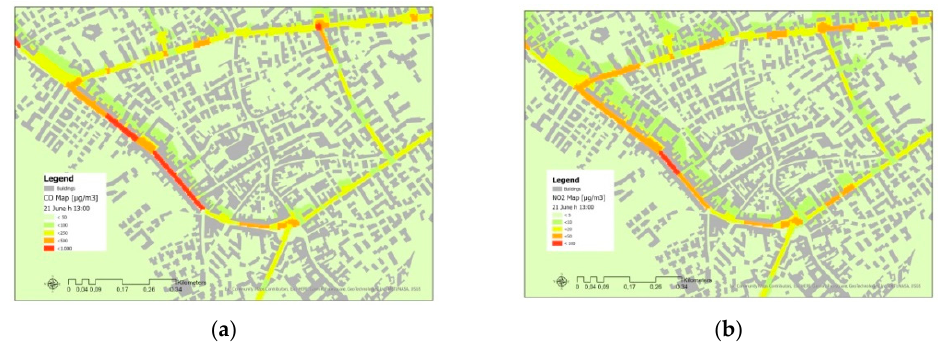
Figure A5. Maps of the estimated concentrations on 21 June at 1 a.m.: ( a ) CO concentrations; ( b ) NO 2 concentrations.